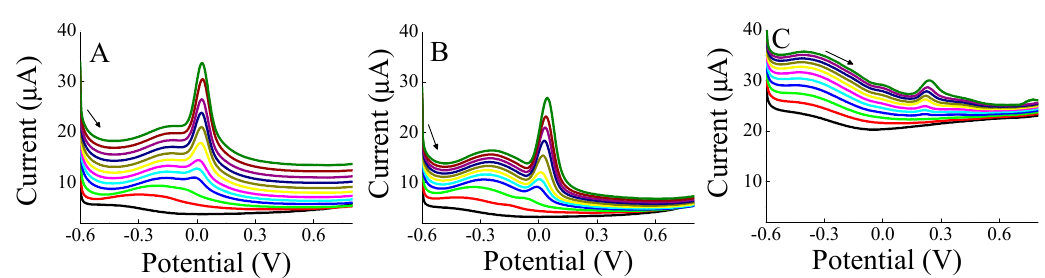
B Figure 2. SEM-FEG images of flexible SPES before ( A ) and after ( B ) electrochemical pretreatment. wt% C 97.4 O Energy (keV) C O Figure 3. EDS spectra for flexible SPEs before ( A ) and after ( B ) electrochemical pretreatment. Figure 4 shows DP voltammograms with flexible SPEs for the individual detection of hydroquinone, catechol, and BPA from oxidation peaks at 0.02 V, 0.03 V, and 0.25 V vs. C, respectively. A comparison in Figure 5 indicates that the slopes of the analytical curves are similar for individual and simultaneous detection: for hydroquinone, the slopes were 0.25 ± 0.01 and 0.28 ± 0.01; for catechol 0.28 ± 0.02 and 0.22 ± 0.01; and for BPA 0.05 ± 0.02 and 0.06 ± 0.01. The oxidation peaks for individual and simultaneous BPA detection were centered at 0.25 and 0.45 (V vs C.), respectively.